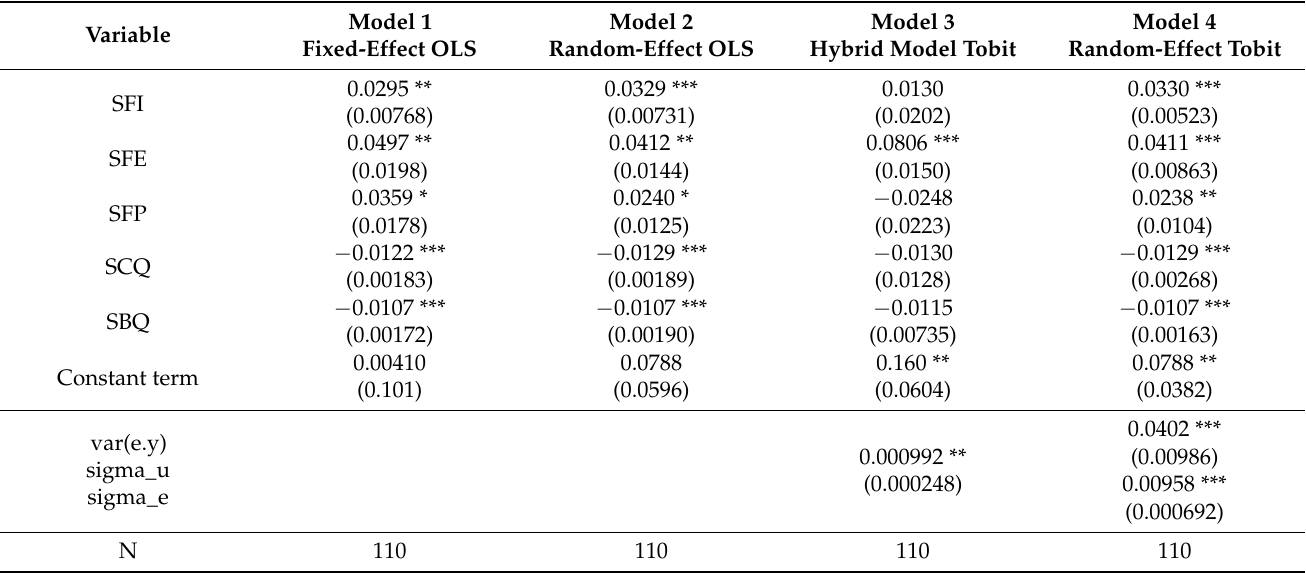
Table 7. Model regression